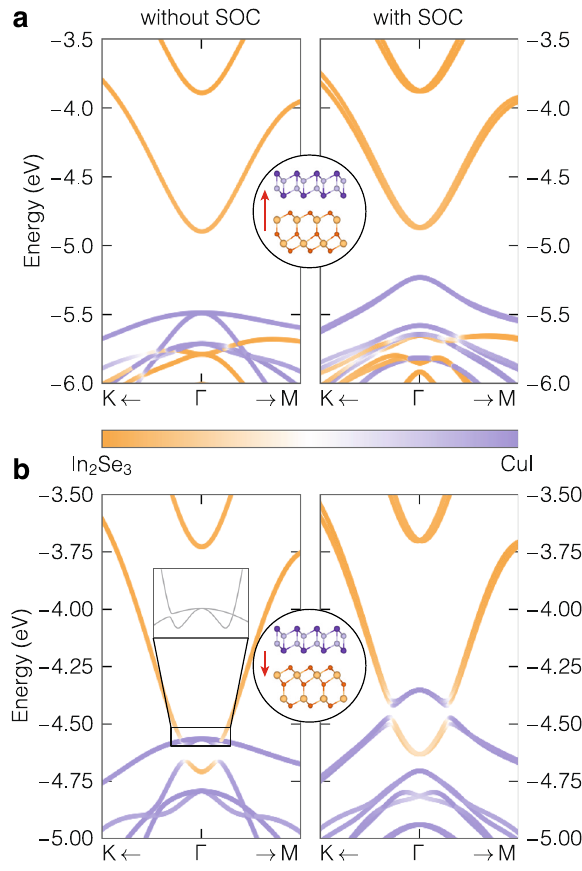
Fig. 3 Energy bands of In 2 Se 3 /CuI heterostructure. Electronic band structure calculated at the PBE-DFT level when the polarization points from In 2 Se 3 to CuI ( a ) or when it points in the opposite direction ( b ). The color coding represents the layer contribution to electronic states, with orange denoting In 2 Se 3 and violet CuI. Results in left (right) panels have been obtained without (with) the effect of spin-orbit coupling. The insets show a lateral view of the heterostructure in the most stable con fi guration, corresponding to a close-packing sequence of the atoms close to the interface. The two polarization states correspond to different band offsets between the monolayers and result, respectively, into a band inversion ( b ) or not ( a ). In the band-inverted case ( b ), the system is metallic without spin-orbit coupling (left), with Dirac crossings between the bands along the Γ -M direction (see inset), while a full band gap of 52 meV opens when spin-orbit coupling is included (right), leading to a quantum spin Hall insulating